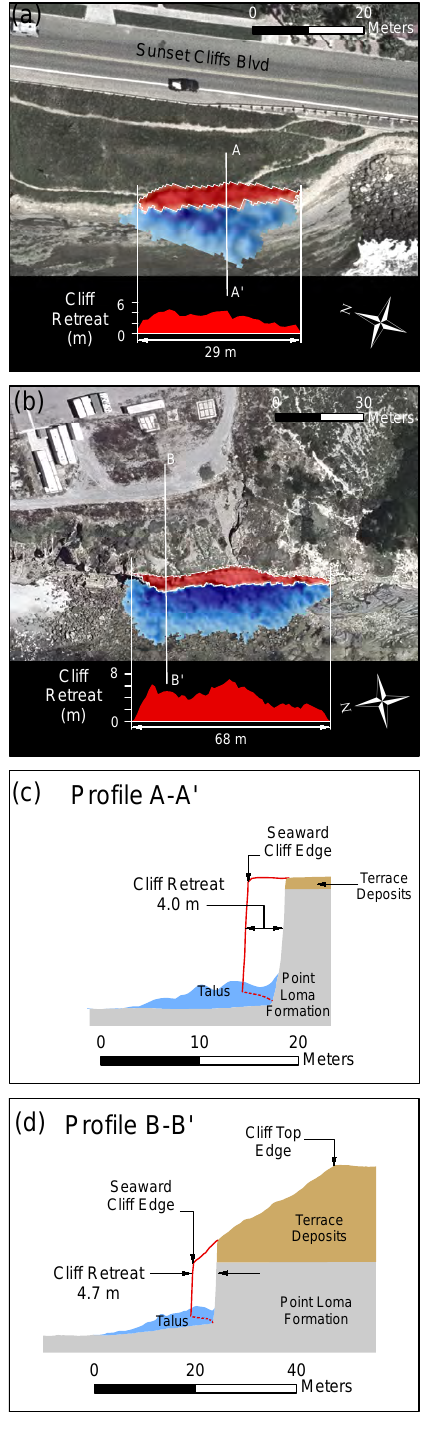
Fig. 3. Areas of large cliff failures (red) and resulting talus deposition (blue) that occurred in (a) Interval 5, and (b) Interval 2. Lower inset: cliff retreat versus alongshore location. (c) Schematic cut-away view on profiles A-A’ and (d) B-B’ before (red line) and after the cliff failures. Typical notch profiles in (c) and (d) were estimated from oblique photos (www.californiacoastline.org). Scale bars in panels (c) and (d) represent both the cross-shore and vertical cliff